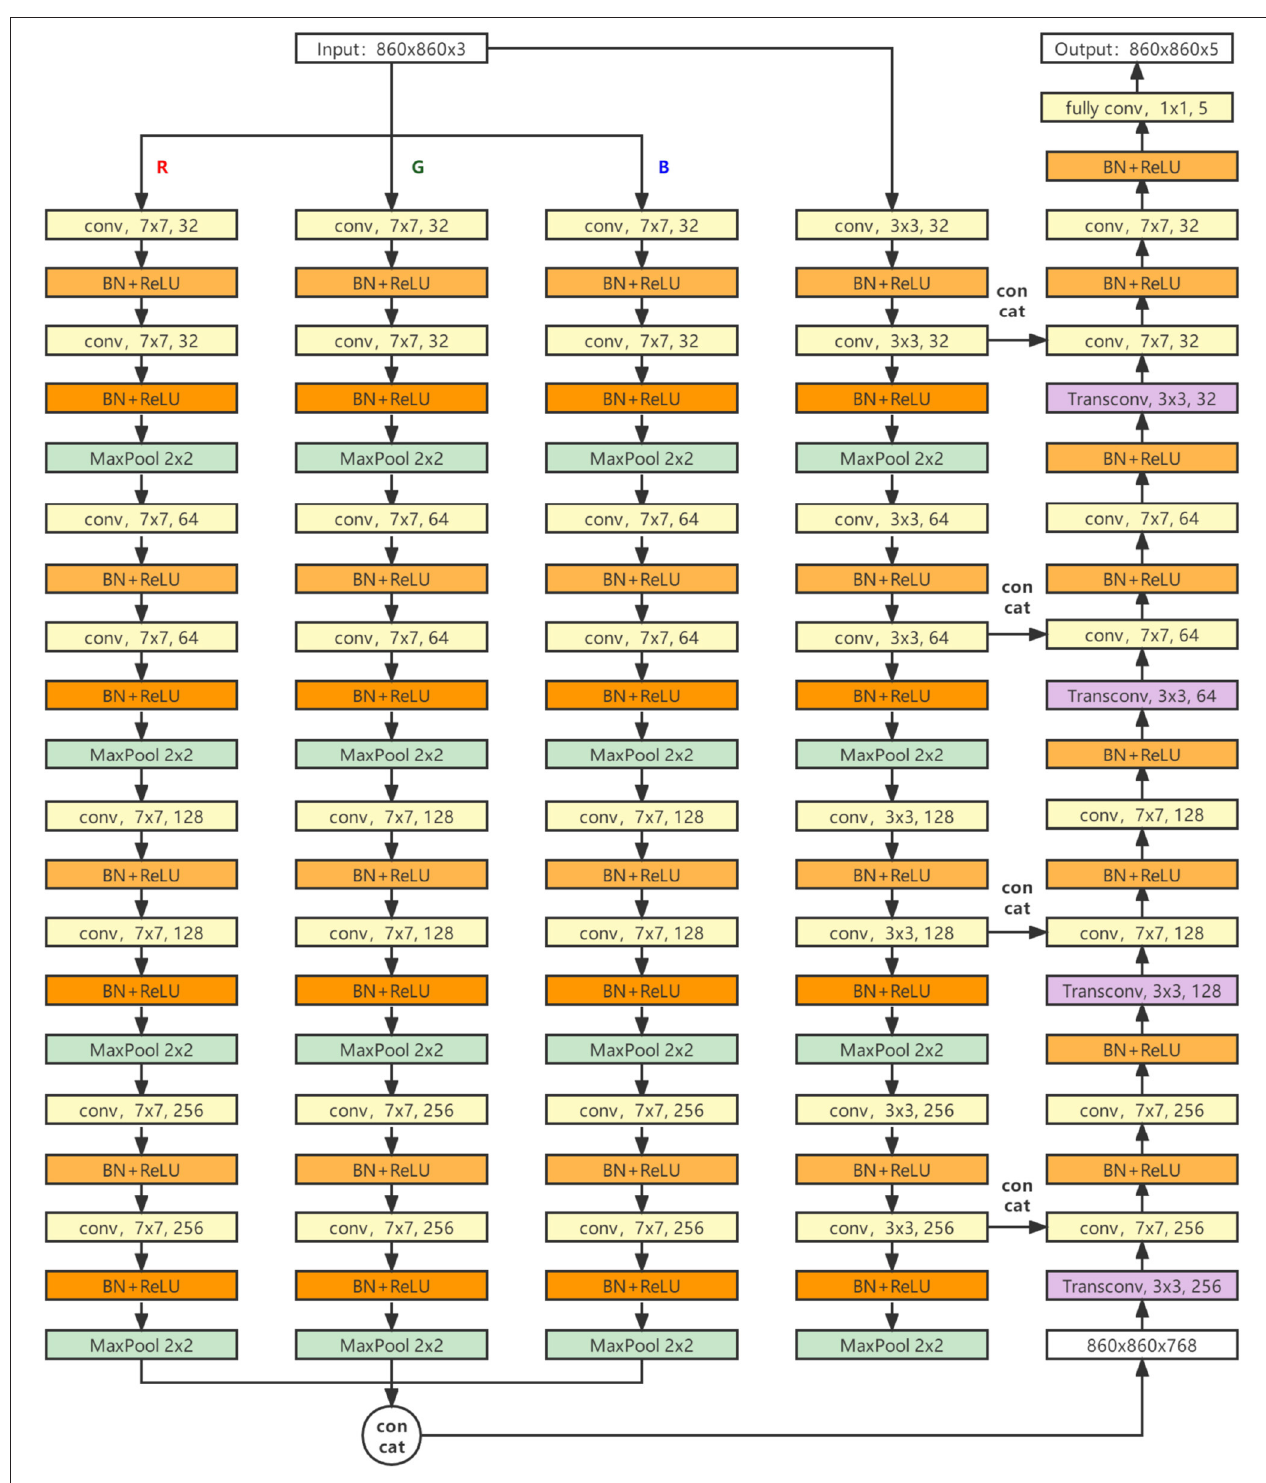
FIGURE 5 | The structure of our model.